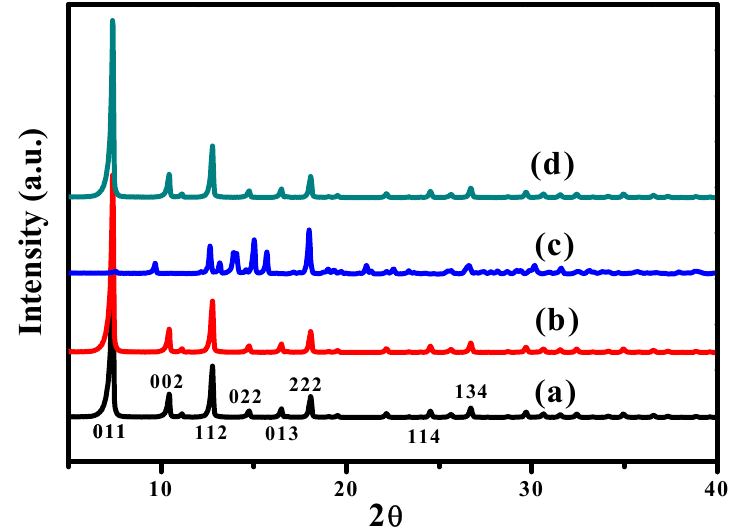
Figure 1. XRD images of ( a ) ZIF-8 ( b ) 2Cu/ZIF-8N4 ( c ) 2Cu/ZIF-8N3 ( d ) 2Cu/ZIF-8N2.